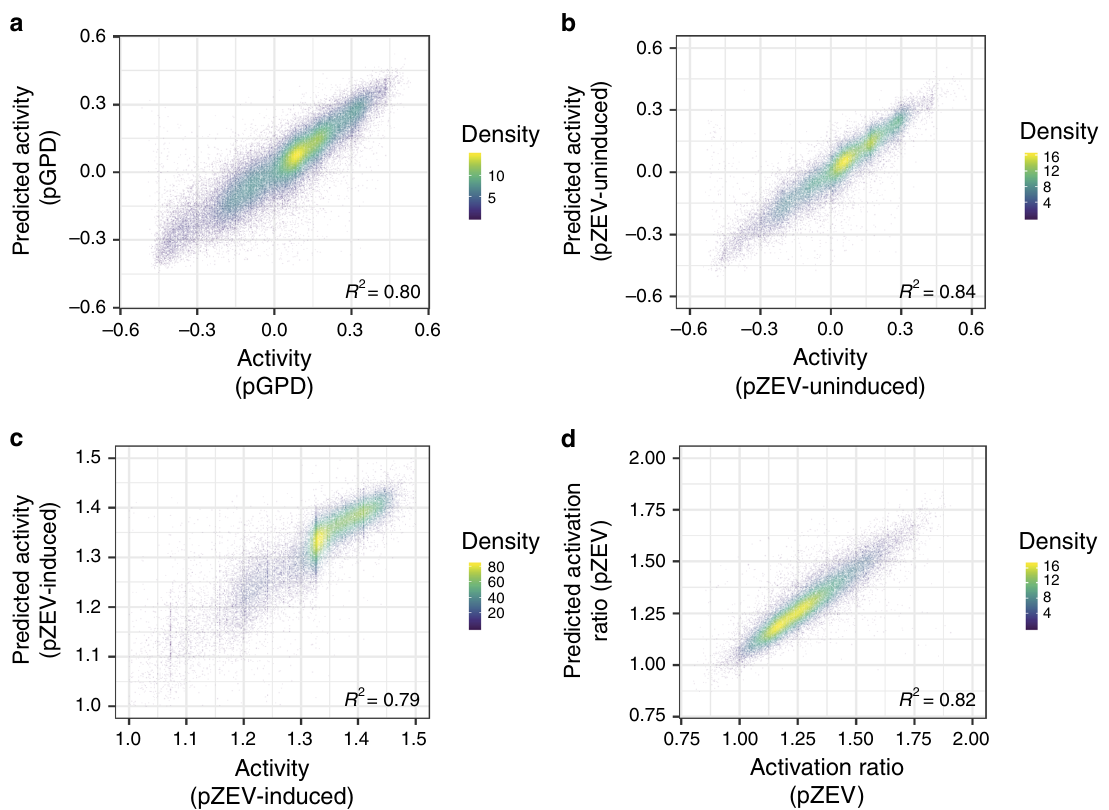
Fig. 2 A neural network ensemble trained on P GPD and P ZEV data accurately predicts promoter activity. Only sequences for which at least ten NextSeq reads were counted in each replicate were used in analyses of P GPD data; only sequences for which at least 20 NextSeq reads were counted in each replicate were used in analyses of P ZEV data. Density: density of plotted points (arbitrary units). a Predicted promoter activities versus FACS-seq measurements for P GPD sequences in the held-out test data. b Predicted promoter activities in the uninduced condition versus FACS-seq measurements for P ZEV sequences in the held-out test data. c Predicted promoter activities in the induced condition versus FACS-seq measurements for P ZEV sequences in the held-out test data. d Predicted activation ratios (ratio of predicted induced and uninduced promoter activities) versus FACS-seq-derived activation ratios for P ZEV sequences in the held-out test